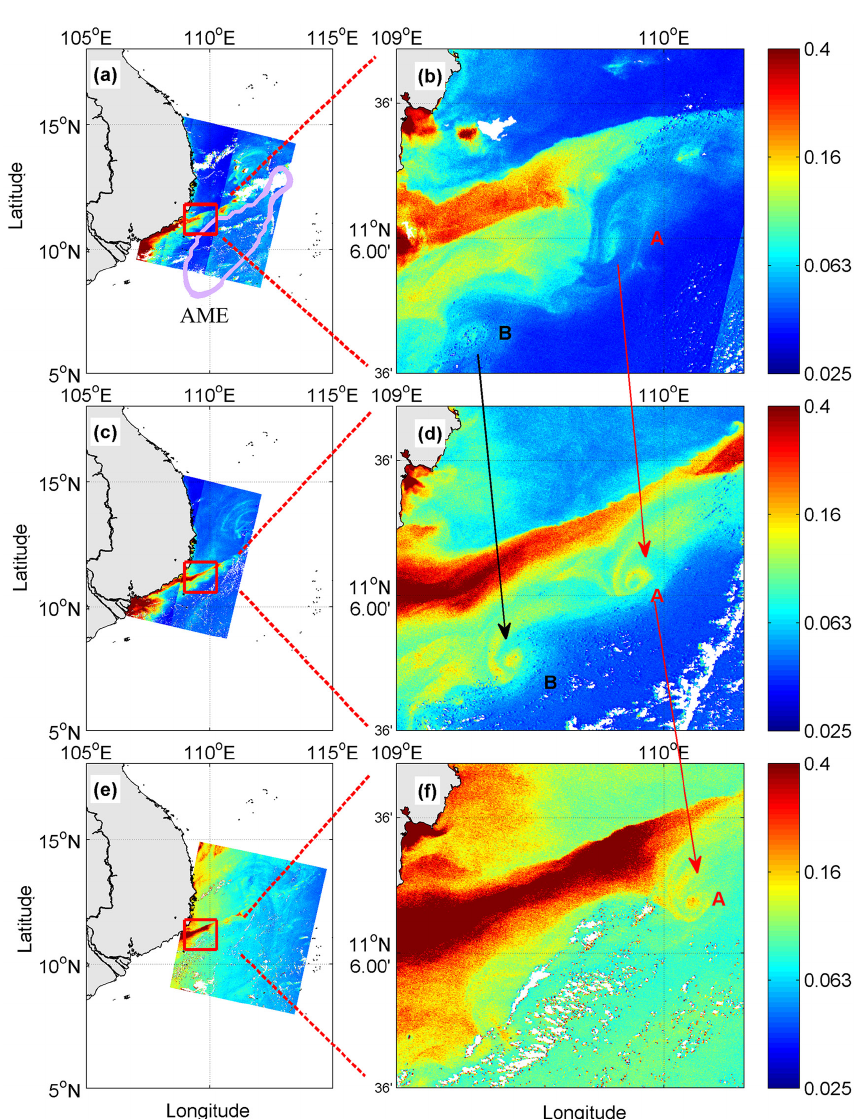
Figure 3. Daily 300m MERIS chlorophyll (mgm − 3 ) on (b) 9 July 2008, (c, d) 12 July 2008, and (e, f) 13 July 2008. The cloud covered area was masked by the white color. A and B indicate two small cyclonic eddies, respectively. The pink circle in (a) denotes the anticyclonic mesoscale eddy (AME) on 9 July 2008, which was derived from AVISO MSLA data following the method of Chelton et al.